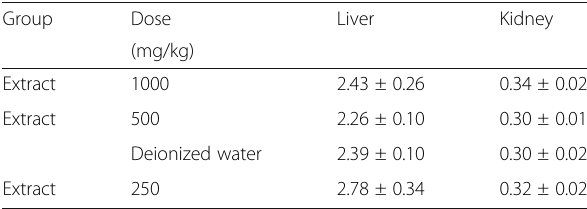
Table 6 Effect of the ethanol fruit extract on the relative organ weights of